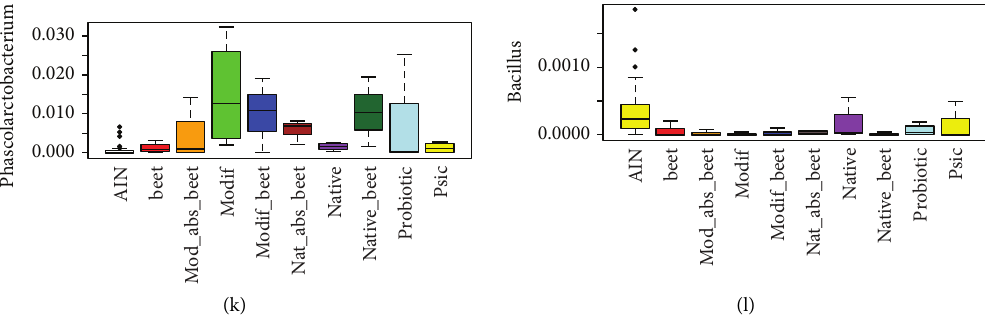
Figure 3: Distribution of the significantly different OTUs (Kruskal-Wallis) with a q -value < 0.05 after 1 week of feeding. AIN: control AIN diet; beet: beet juice; Mod_abs_beet: modified taro starch with absorbed beet juice; Modif: modified taro starch; Modif_beet: modified taro starch combined with beet juice by gavage; Nat_abs_beet: taro starch with absorbed beet juice; Native: native taro starch; Native_beet: native taro starch combined with beet juice by gavage; Probiotic: L.plantarum IS-10506; Psic: psicose. (a) Lactococcus ; (b) Eubacterium ; (c) Coriobacteriaceae; (d) Bifidobacteriaceae; (e) Leuconostoc ; (f) Peptococcaceae; (g) Bifidobacterium ; (h) Anaerovibrio ; (i) Enterobacteriaceae; (j) Christensenellaceae; (k) Phascolarctobacterium ; (l) Bacillus